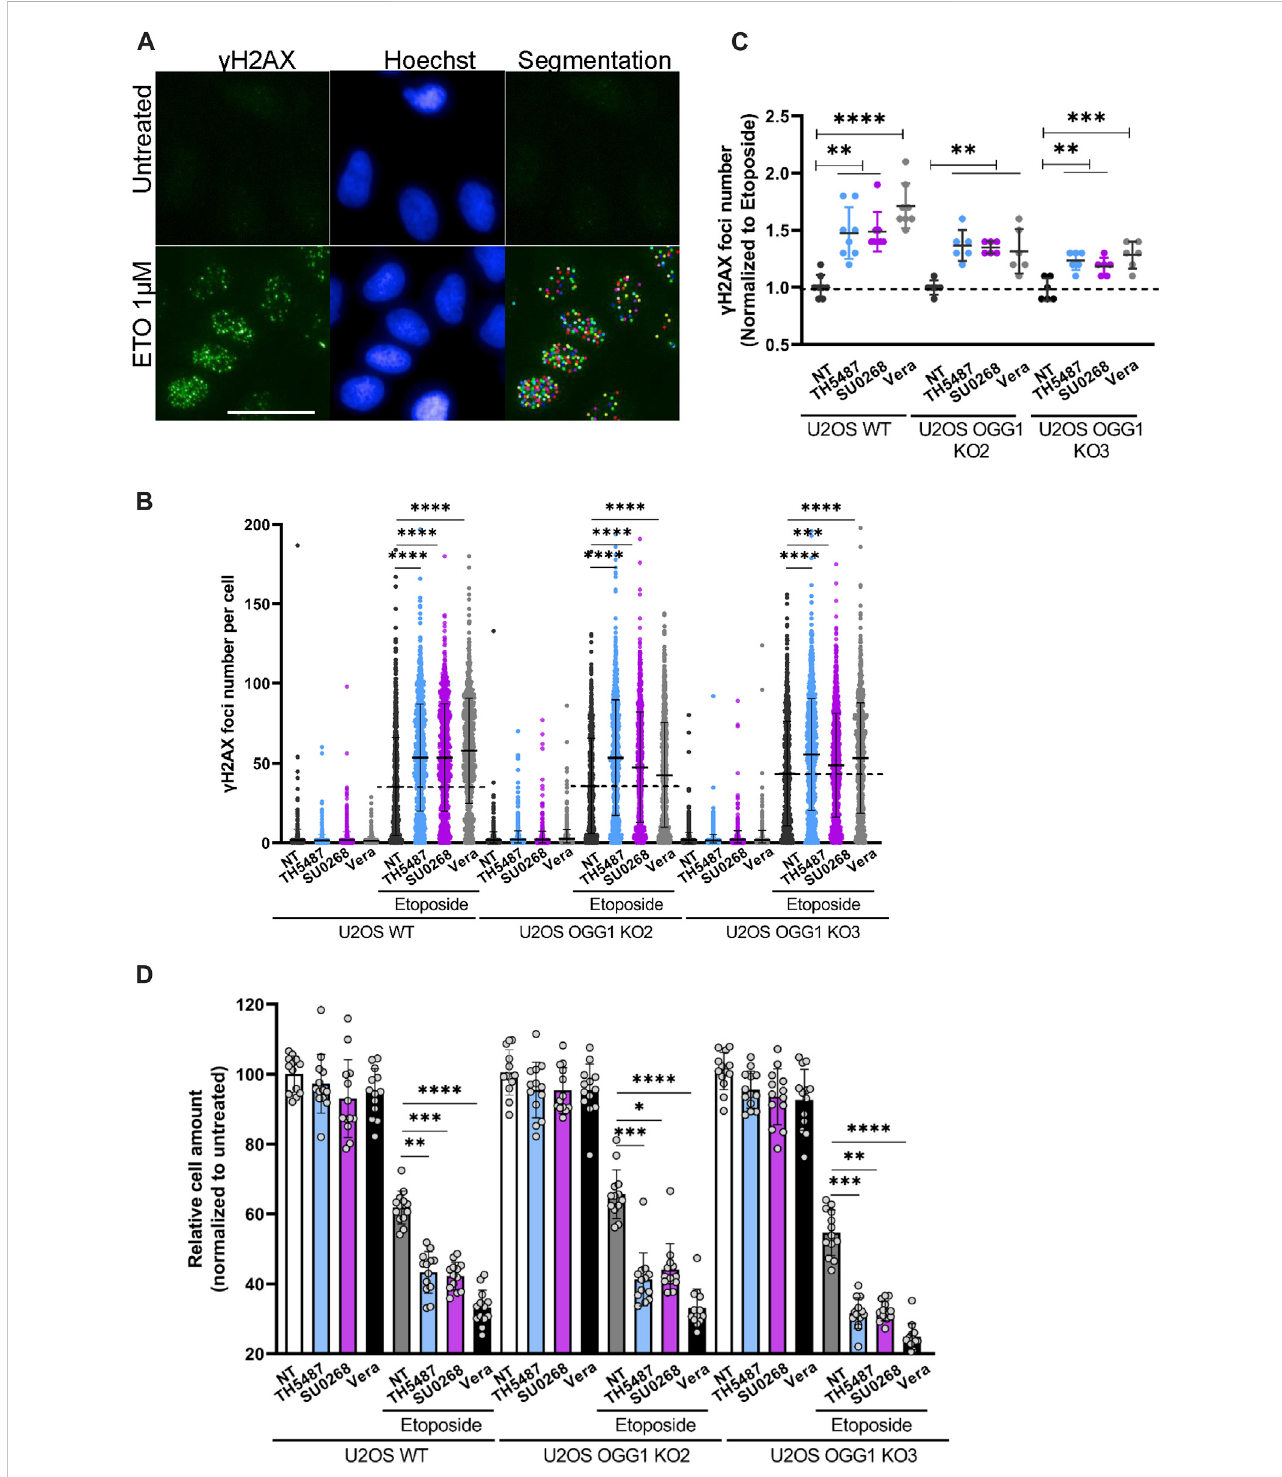
OGG1 inhibitors TH5487 and SU0268 increase the effects of the chemotherapeutical drug Etoposide, independently of OGG1. (A) U2OS WT and OGG1 KO cells were exposed to Etoposide alone or in combination with 10 µM of TH5487, SU0268 or Verapamil. Immediately after exposure to the drugs, cells were fi xed and DSB were visualized by immuno fl uorescence using an antibody against γ H2AX (green). Nuclei were stained with Hoechst 33342 (blue). Statistical analysis was performed with a Kruskal Wallis test. A segmentation algorithm was used to quantify γ H2AX foci number in at least 1000 cells for each condition. Scale bar 50 µm. (B) Distribution of γ H2AX foci number per nuclei is presented for a representative experiment out of three. Statistic analysis wasperformedwithaKruskalWallistest(***) p < 0.001;(****) p < 0.0001. (C) Thenumberof γ H2AXfocipernucleiwasnormalizedtothenumberoffociincells exposed to Etoposide and the mean from three independent experiments is represented in the graph. Statistical analysis was performed with a Kruskal Wallis test (**) p < 0.01; (***) p < 0.001; (****) p < 0.0001. (D) Cell survival was evaluated in U2OS WT and OGG1 KO cells, 4 days after exposure to a single treatment with Etoposide or a combined treatment with Etoposide and 10 µM of TH5487, SU0268 or Verapamil. The number of cells were normalized to the untreated control cells. The mean of three independent experiments is represented in the graph. Statistical analysis was performed with a Kruskal Wallis test (*) p < 0.05; (**) p < 0.01; (***) p < 0.001; (****) p <